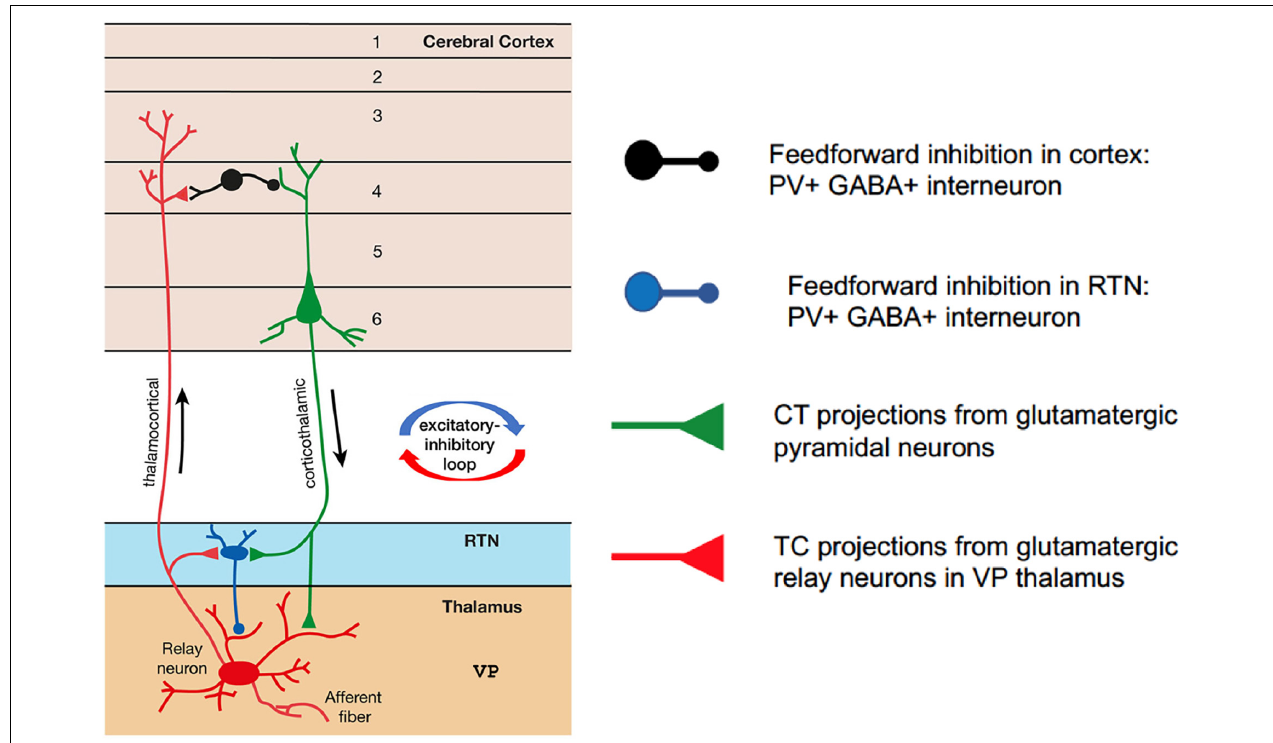
FIGURE 1 | Simplified schematic of the corticothalamocortical (CTC) network in the rodent brain. Relay neurons in the ventral posterior (VP) thalamus are reciprocally connected with the pyramidal neurons in the cortex. Feedforward PV + inhibitory interneurons in the reticular thalamic nucleus (RTN) project onto the relay neurons and are excited at AMPA synapses by corticothalamic projections from pyramidal cells. Feedforward PV + inhibitory interneurons in the cortex are excited at AMPA synapses by thalamocortical projections from relay neurons in VP